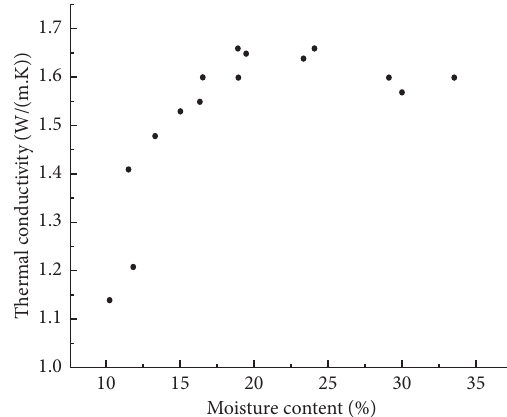
Figure 9: Thermal conductivity change with moisture content.